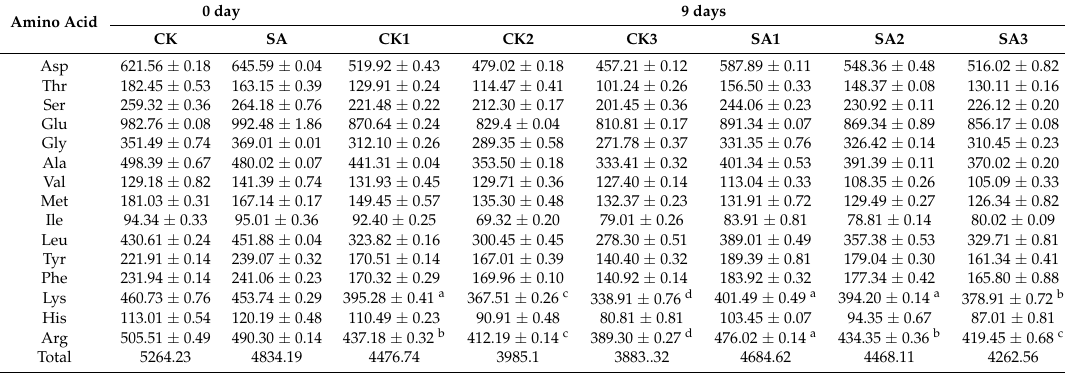
Table 6. Effect of CFS from A. sobria on amino acid content of Pacific white shrimp ( L. vannamei ). Amino Acid